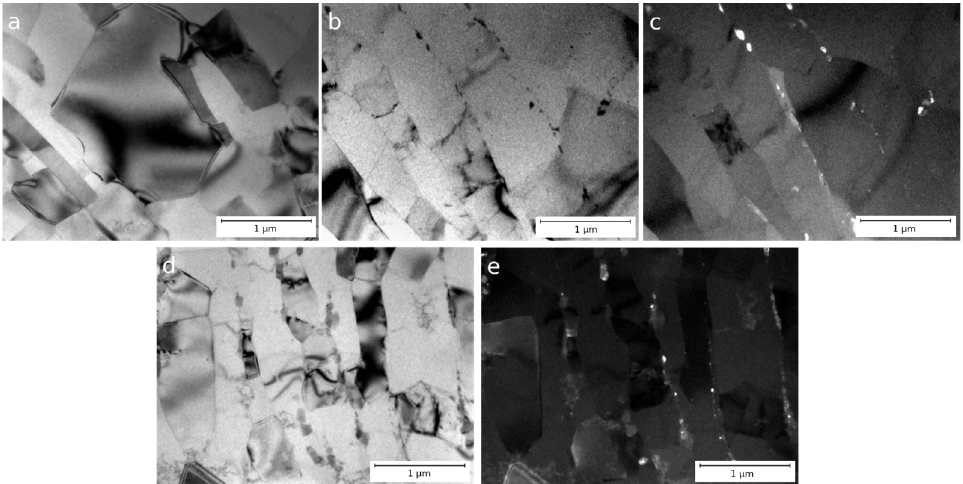
Figure 6. Microstructure of Al–1.7Fe alloys after ECAP, CR, and subsequent annealing at 280 °C for 1 h: ( a – c ) CC and ( d , e ) EMC, longitudinal section,